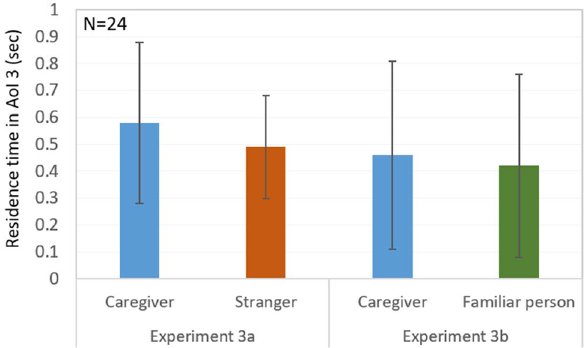
Figure 3. The dogs’ average residence time (in seconds) in the Area of Interest 3 in Experiments 3a and 3b. The 95% confidence intervals are indicated by the vertical black lines. The mean residence time for the caregiver is depicted in blue, for the stranger in dark orange, and for the familiar person in green